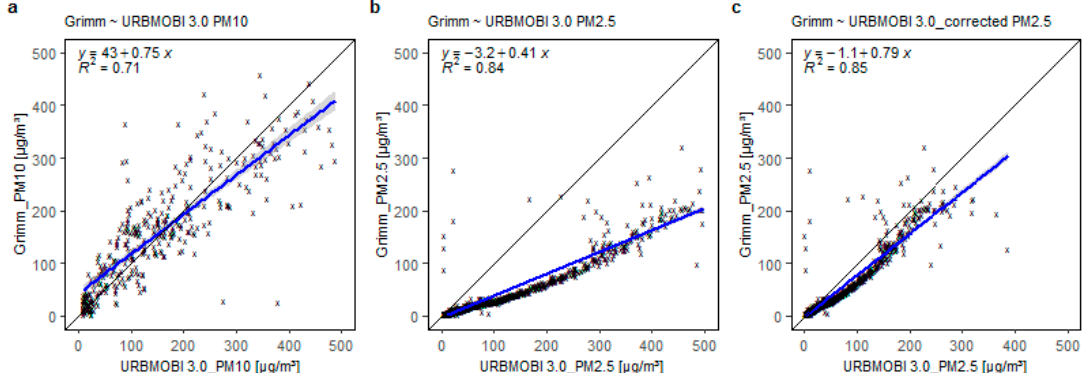
Figure 4. Results of the calibration tests recorded by the URBMOBI 3.0 (metal housing) and the reference instrument (Grimm 1.108) inside the particle generator with a time integral of 6 s; ( a ) PM10 scatter plot between Grimm 1.108 raw data and URBMOBI 3.0; ( b ) PM2.5 scatter plot between Grimm 1.108 and URBMOBI 3.0 raw data; ( c ) PM2.5 scatter plot between Grimm 1.108 raw data and URBMOBI 3.0 data corrected using the compensation function.